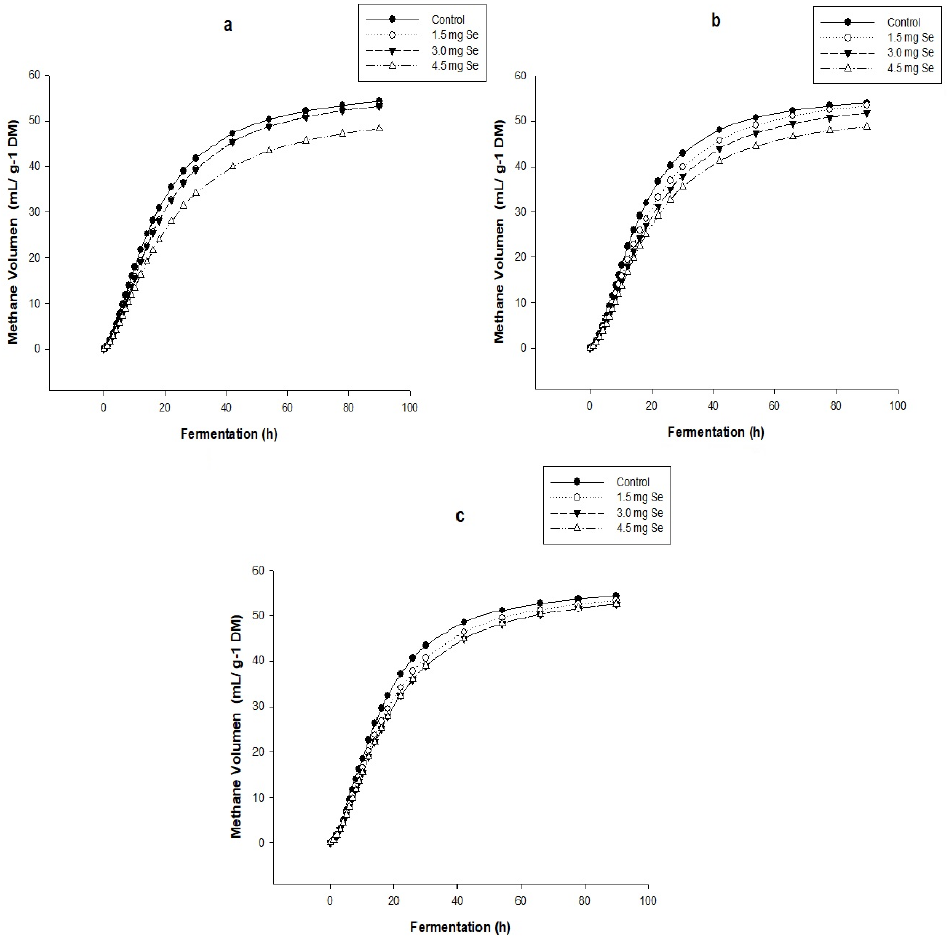
Figure 2. Accumulated methane production profile during the 92h fermentation in the different treatments and different harvests. ( a ) the first harvest; ( b ) the second harvest; ( c ) the third harvest.